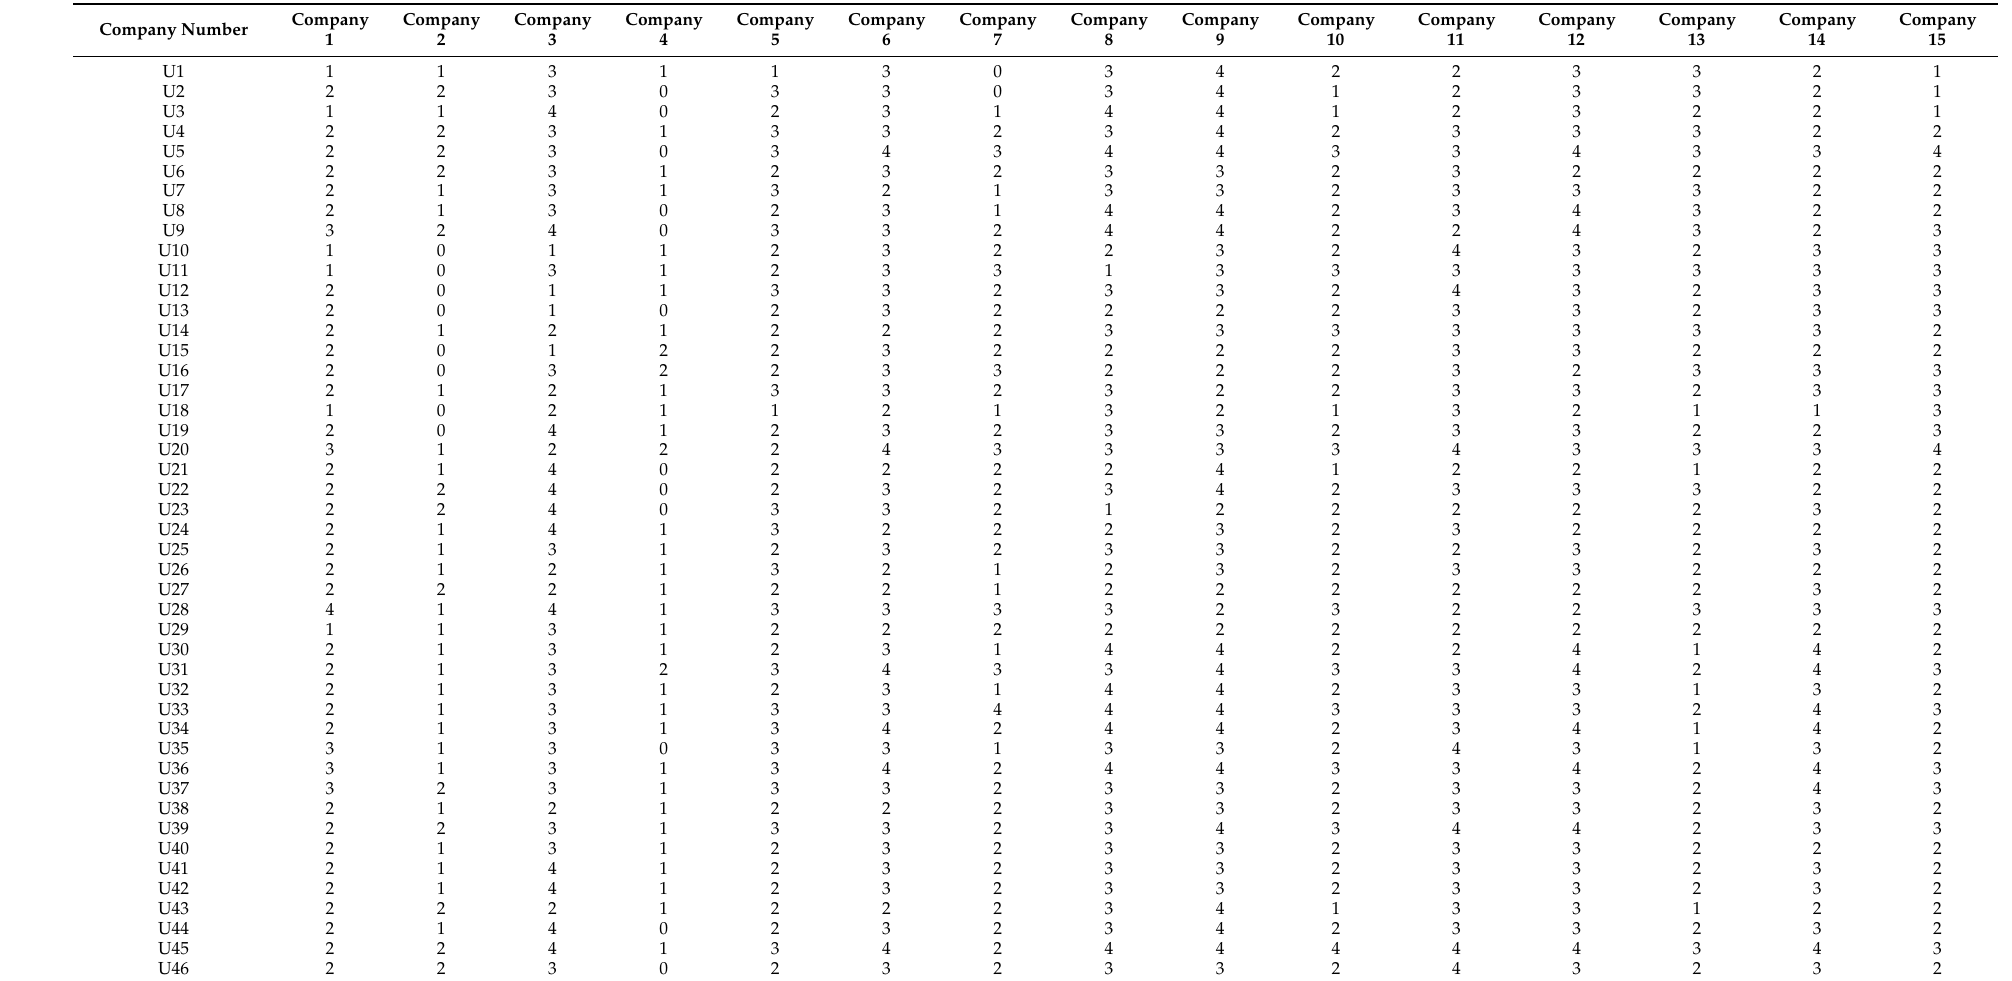
Table A2. List of companies with points earned from the